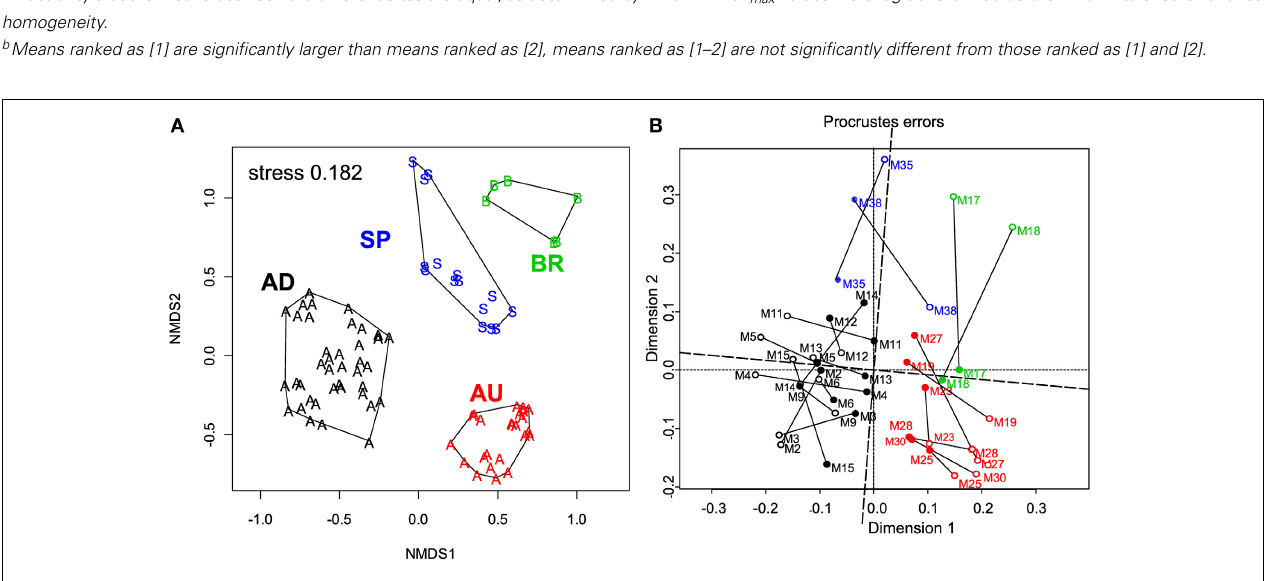
between the composition and function of the microbial communities in the studied mats. Open symbols represent the ARISA-based NMDS data, while the closed ones represent the functional data ( Figure 4 ). Note the small rotation angle between the two sets of ordination axes. AD